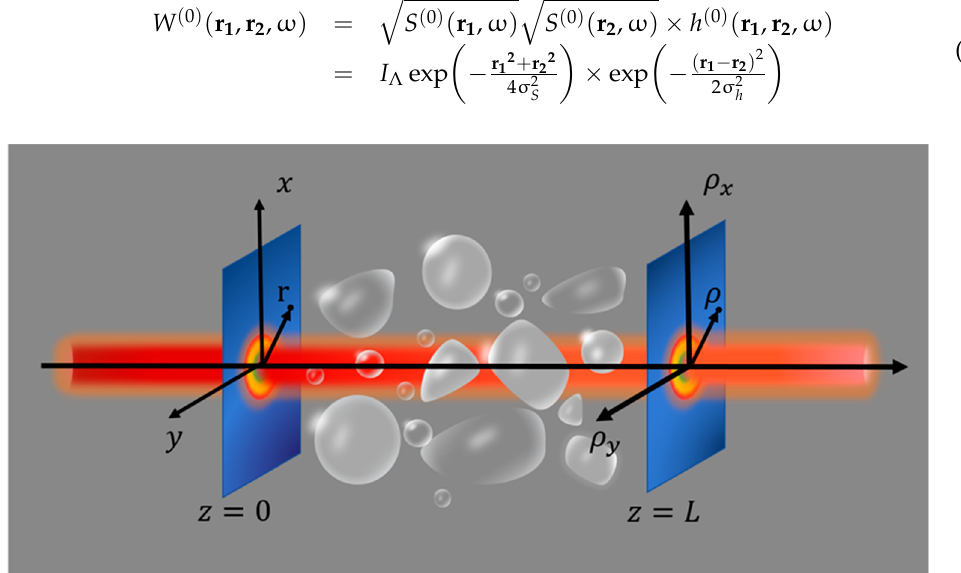
Figure 3. Schematic diagram of the light wave passing through a turbulent atmosphere from the incident surface and reaching the exit surface.